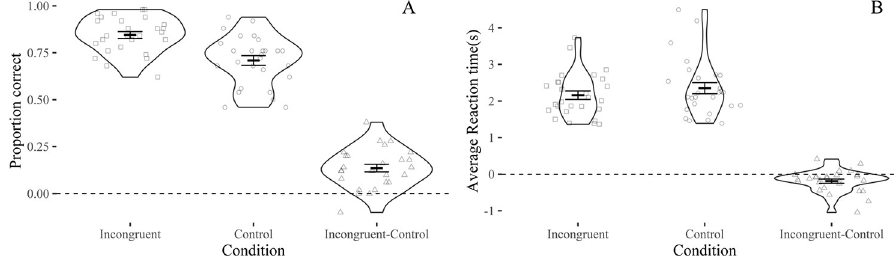
Fig 3. Results from the memory test in terms of accuracy (A) and reaction times (B) for incongruent and control images, and as the difference between the two conditions. Each dot represents a participant, bars show the group average and the standard error of the